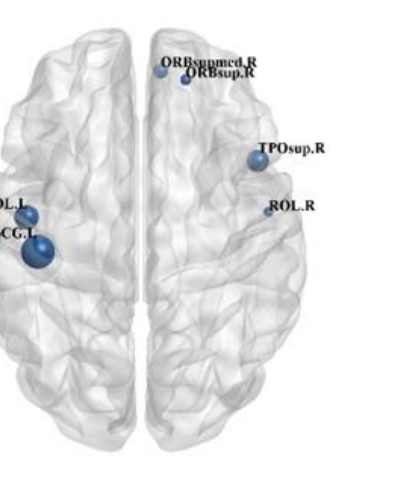
Figure 2. Group comparisons of the temporal variability of nodal efficiency. Right rolandic operculum (ROL.R), right orbital part of superior frontal gyrus (ORBsup.R), right medial orbital part of superior frontal gyrus (ORBsupmed.R), right temporal pole: superior temporal gyrus (TPOsup.R), left rolandic operculum (ROL.L), and left postcentral gyrus (PoCG.L). ** significant at 0.01 level, and * significant at 0.05 level (2-tailed).